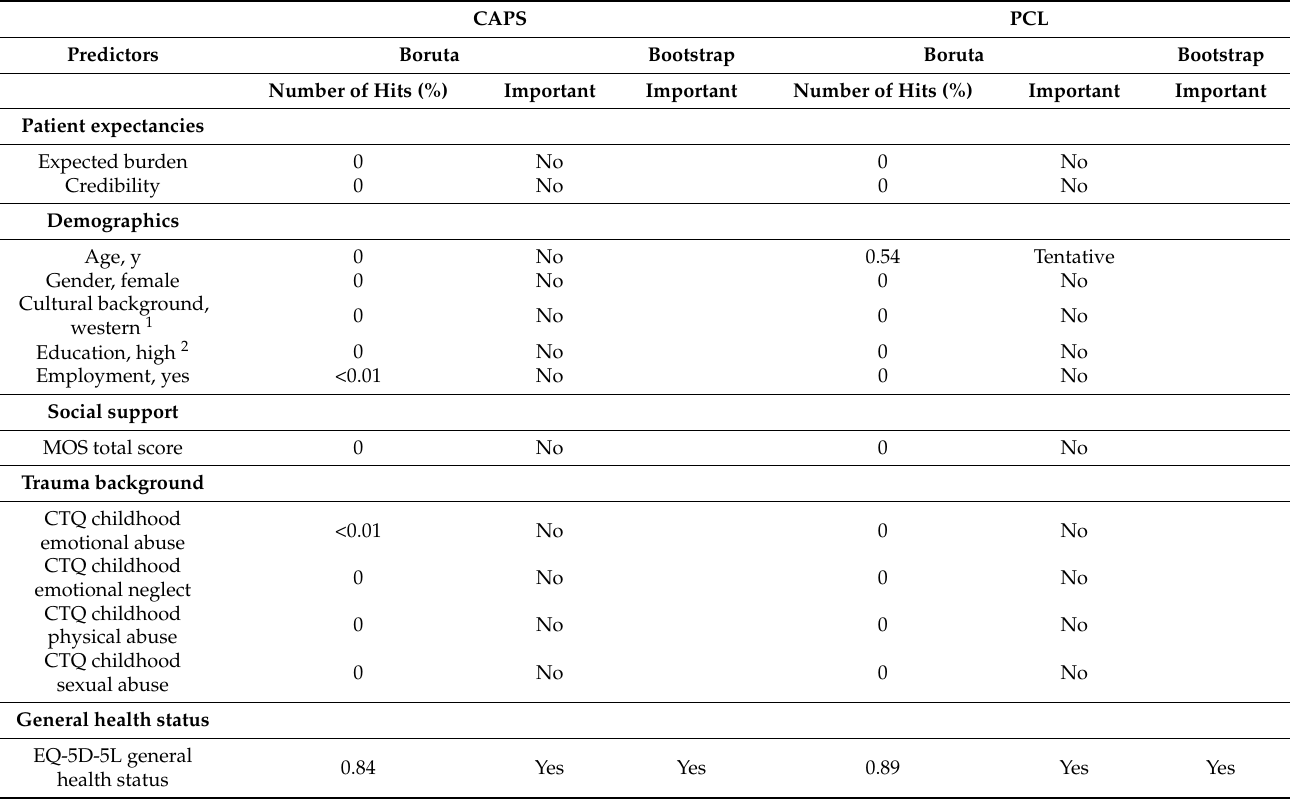
Table A2. Results from Boruta and subsequent bootstrap procedure for potential predictors of